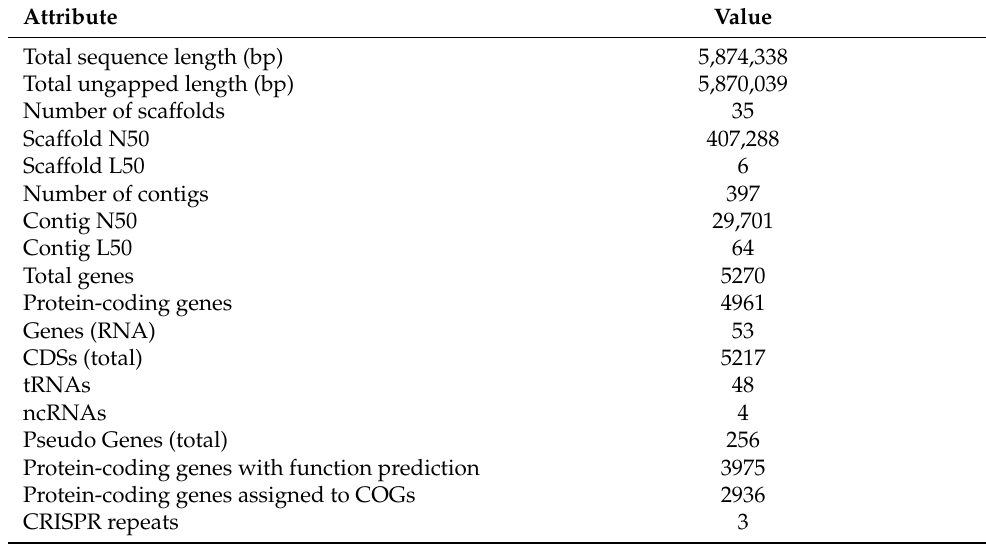
Table 1. Genomic features, gene prediction and annotation summary of the Pseudomonas sp. PICF6